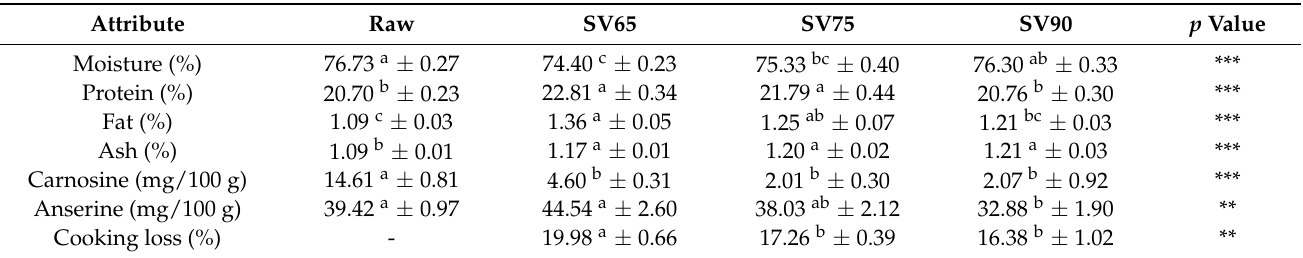
Table 2. Changes in the chemical composition during thermal treatment of pikeperch tissue (mean values and standard error of mean in